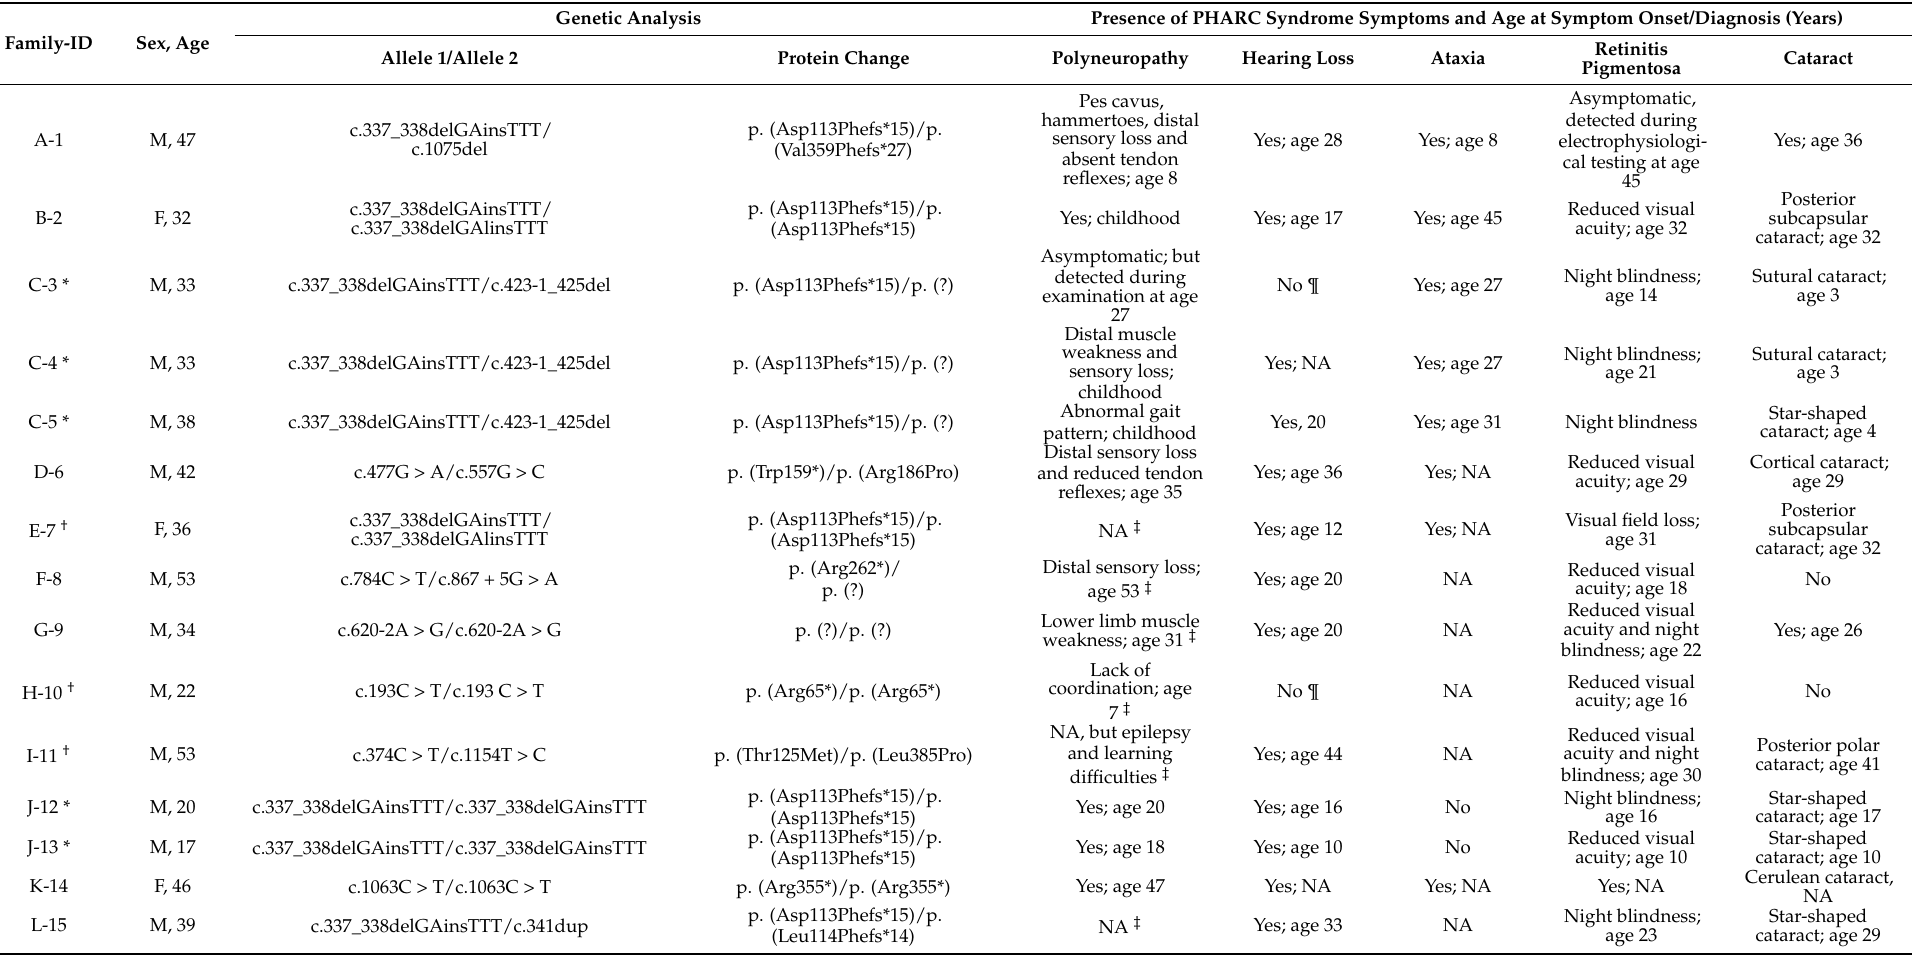
Table 1. Genetic and clinical characteristics at last examination of patients with biallelic ABHD12